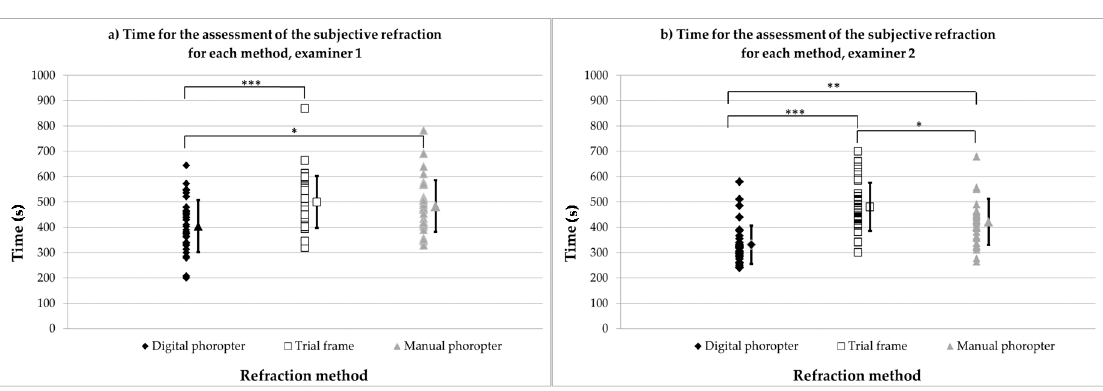
Figure 2. Individual and average data (±1 standard deviation) for the time of the assessment of the subjective refraction for each method, separated for examiner 1 ( a ) and examiner 2 ( b ). * = p < 0.05; ** = p < 0.01; *** = p < 0.001.